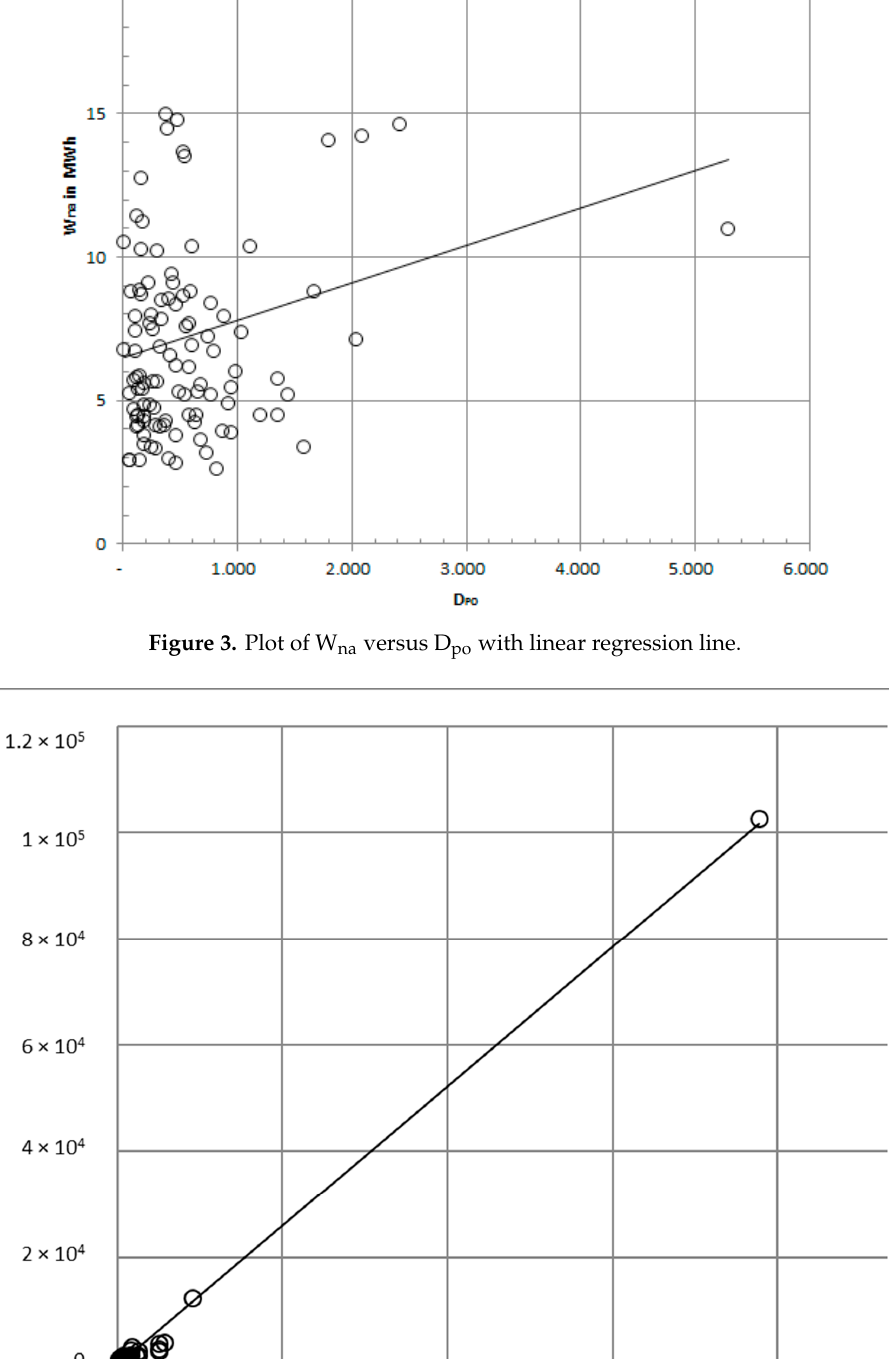
Figure 4. Plot of l c versus n gc with regression line.